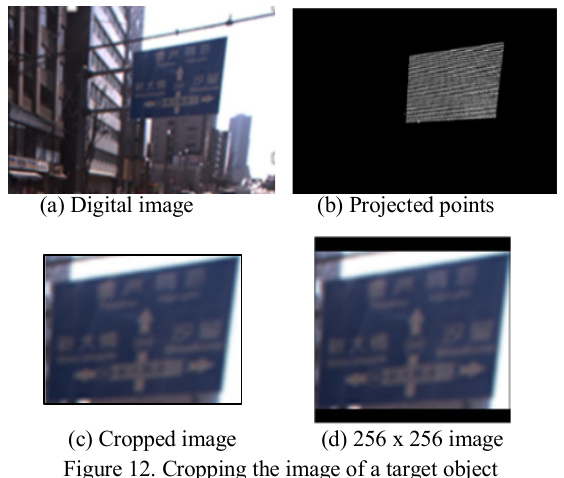
Figure 12. Cropping the image of a target